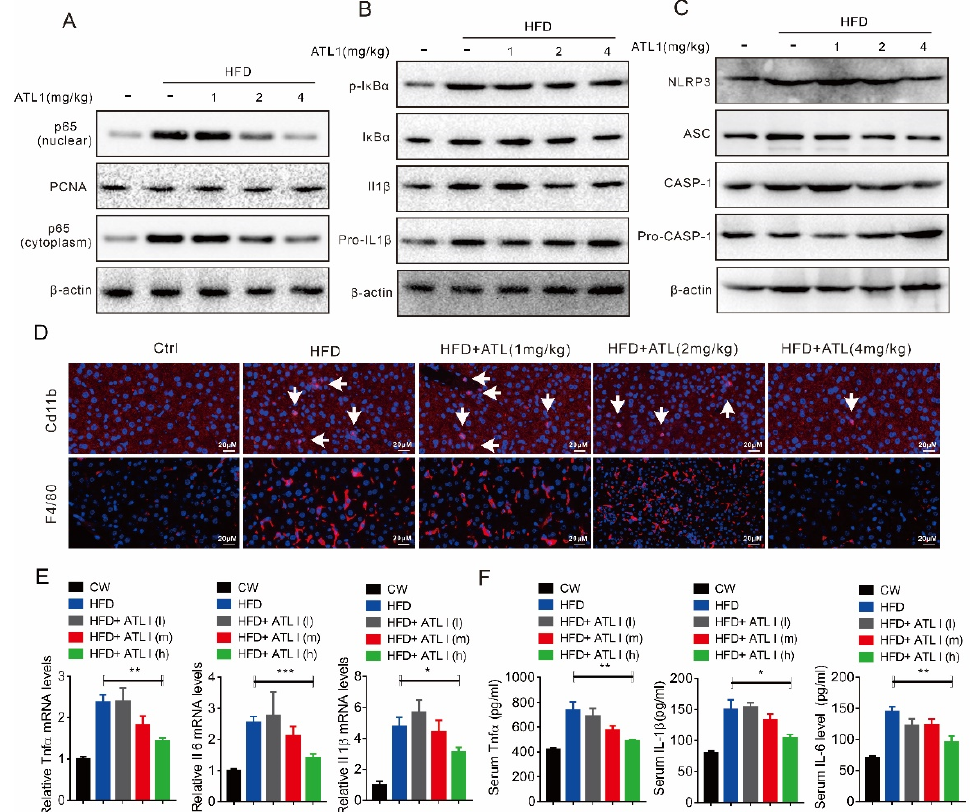
Figure 4. ATL I treatment suppressed NLRP3 inflammasome and inflammatory response in HFD- induced obese mice. ( A ) Western blot indicated that ATL I treatment significantly decreased the HFD-induced p65 levels in the nuclei of mouse livers. ( B , C ) ATL I treatment significantly decreased the HFD-induced expression of proteins related to NLRP3 inflammasome formation in mouse livers. ( D ) Immunofluorescence data indicated a decreased level of Cd11b and F4/80 positive cells in HFD-induced obese mice after ATL I treatment. ( E ) ATL I treatment effectively reversed the mRNA levels of inflammatory genes in HFD-induced obese mice after ATL I treatment. ( F ) ELISA data showed an obviously decreased level of serum inflammatory cytokines levels in HFD-induced obese mice after ATL I treatment. Results are shown as mean ± SEM (n ≥ 4). * p < 0.05, ** p < 0.01, *** p < 0.001 versus the HFD group.